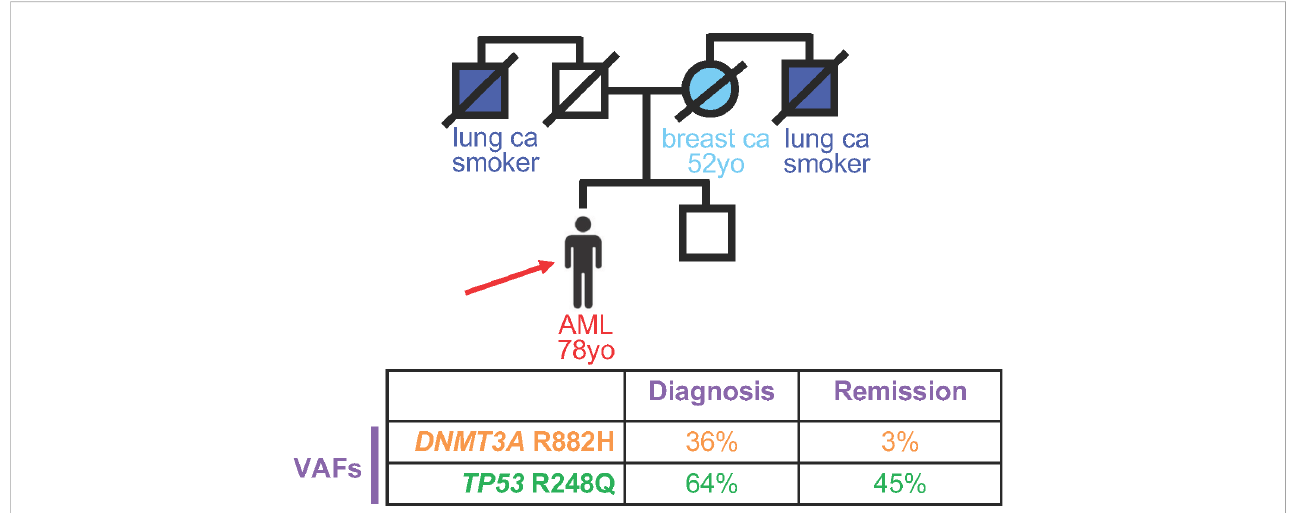
FIGURE 1 Persistence of deleterious variants in genes known to confer germline risk to hematopoietic malignancies suggests germline status. Top, Pedigree of an individual diagnosed with acute myeloid leukemia (AML) at 78 years old (yo), indicated by the red arrow. Circles, women; squares, men. Strike-out line indicates deceased individual at the time of pedigree generation. Ca, cancer. Bottom, Variant allele frequency (VAF) of deleterious variants at diagnosis (left) versus remission